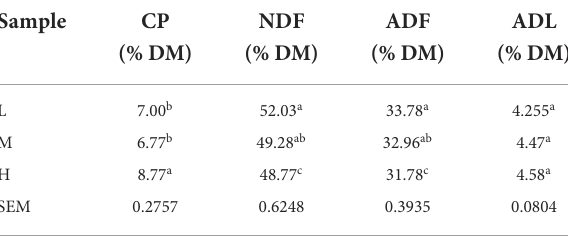
TABLE 1 Chemical composition of intercropped fresh materials before